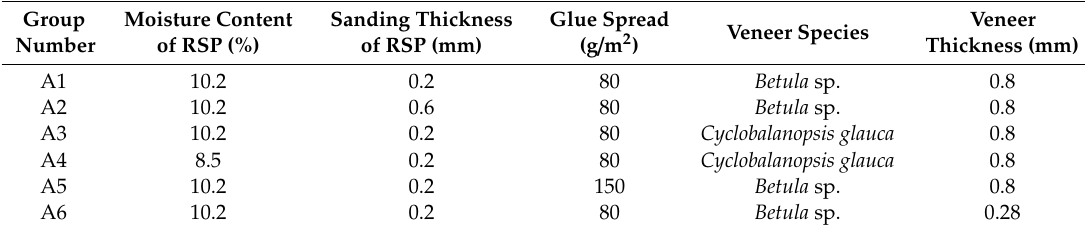
Table 2. Group number and treatment of specimens.